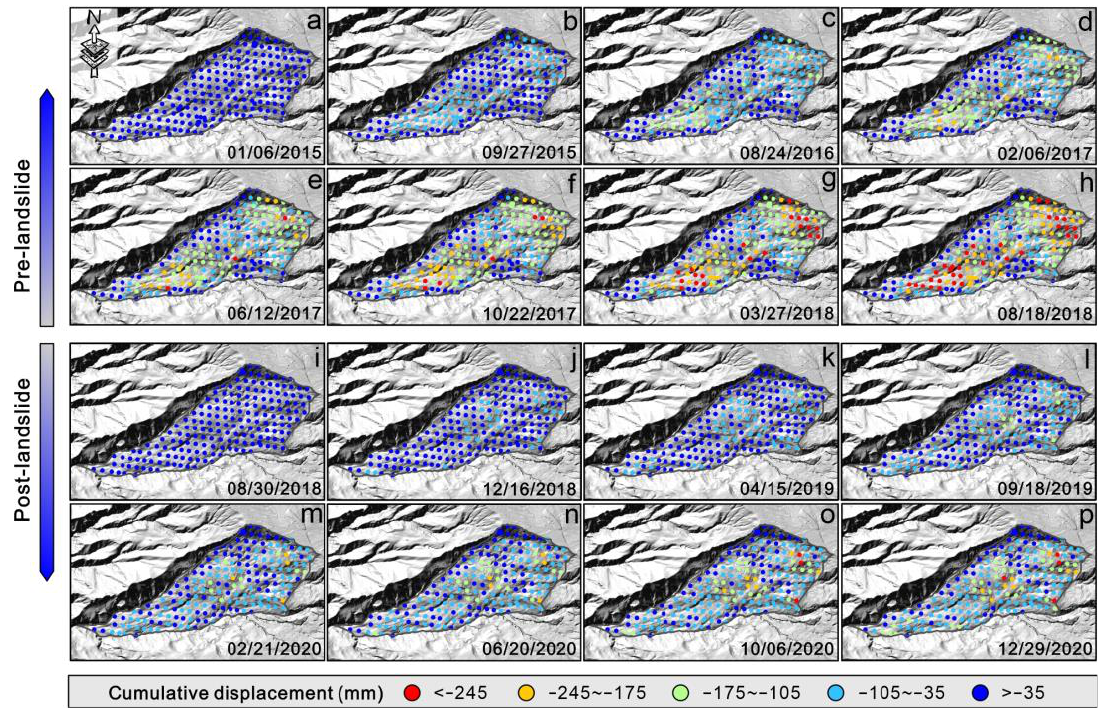
Figure 6. Cumulative displacement graphs. ( a – h ) Cumulative displacement before the landslide. ( i – p ) Cumulative displacement after the landslide.